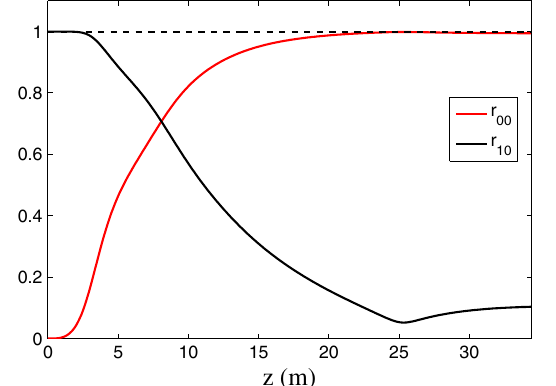
and r —defined by Eq. (60)— 00 10 seed. 10